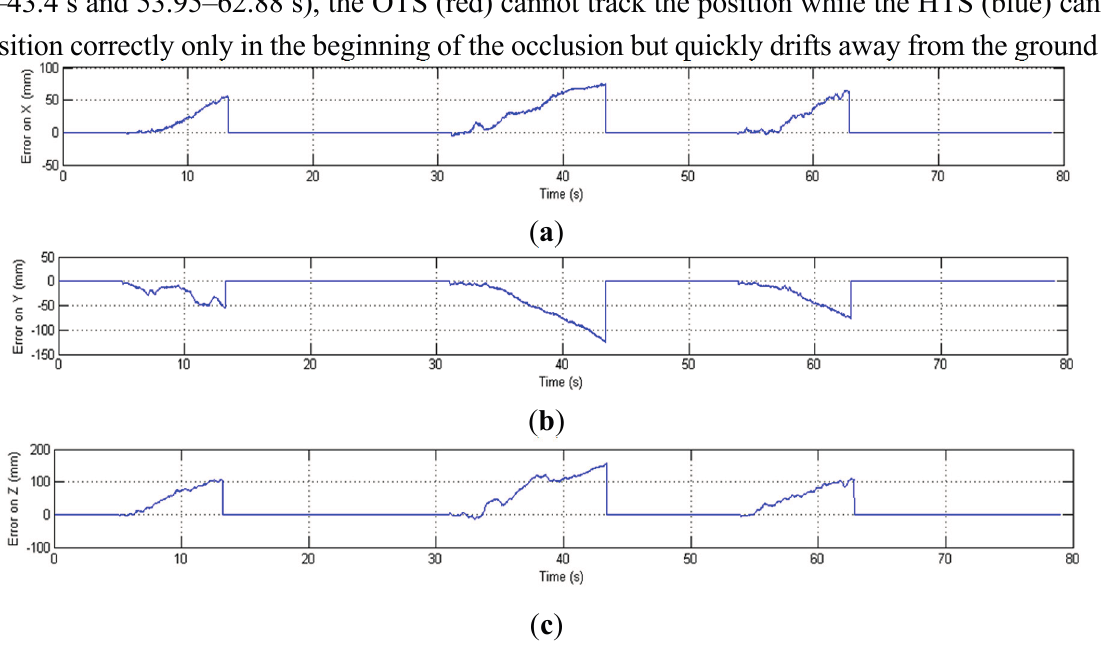
Figure 14. Position error (mm) in three-axes versus time; error increases in cases of full OTS occlusion (times corresponding to dashed red lines in Figure 13). ( a ) Error of position on X-axis; ( b ) Error of position on Y-axis; ( c ) Error of position on